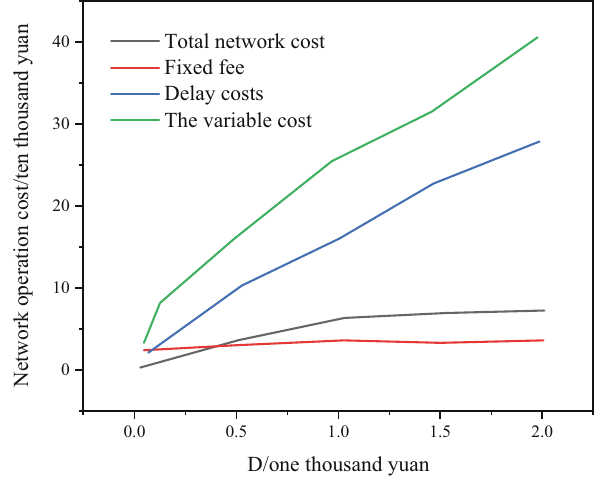
Figure 5: Computer simulation results of di ff erent weighted coe ffi cients of fi xed